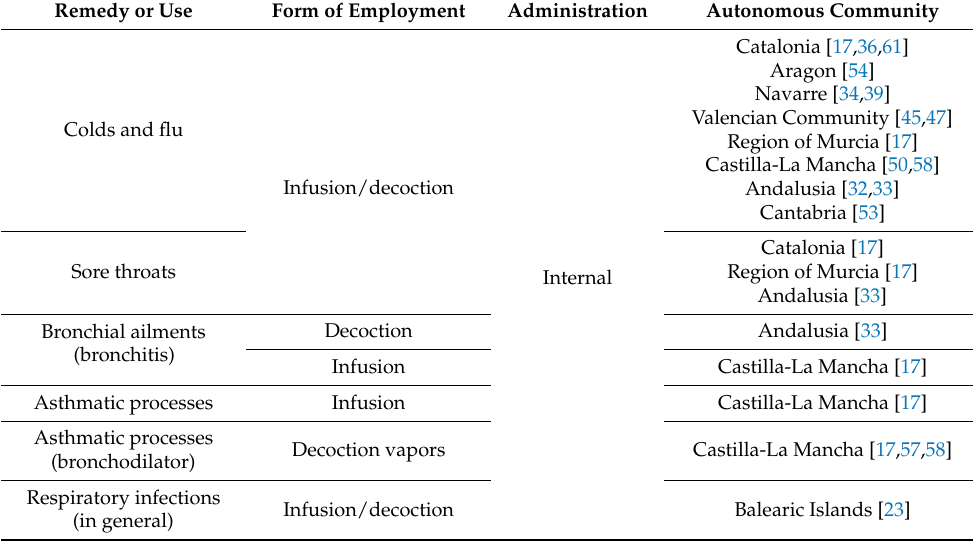
Table 6. Compilation of the medicinal uses of Chiliadenus glutinosus as a remedy for diseases of the respiratory system in Spain, compiled from the existing specific literature.